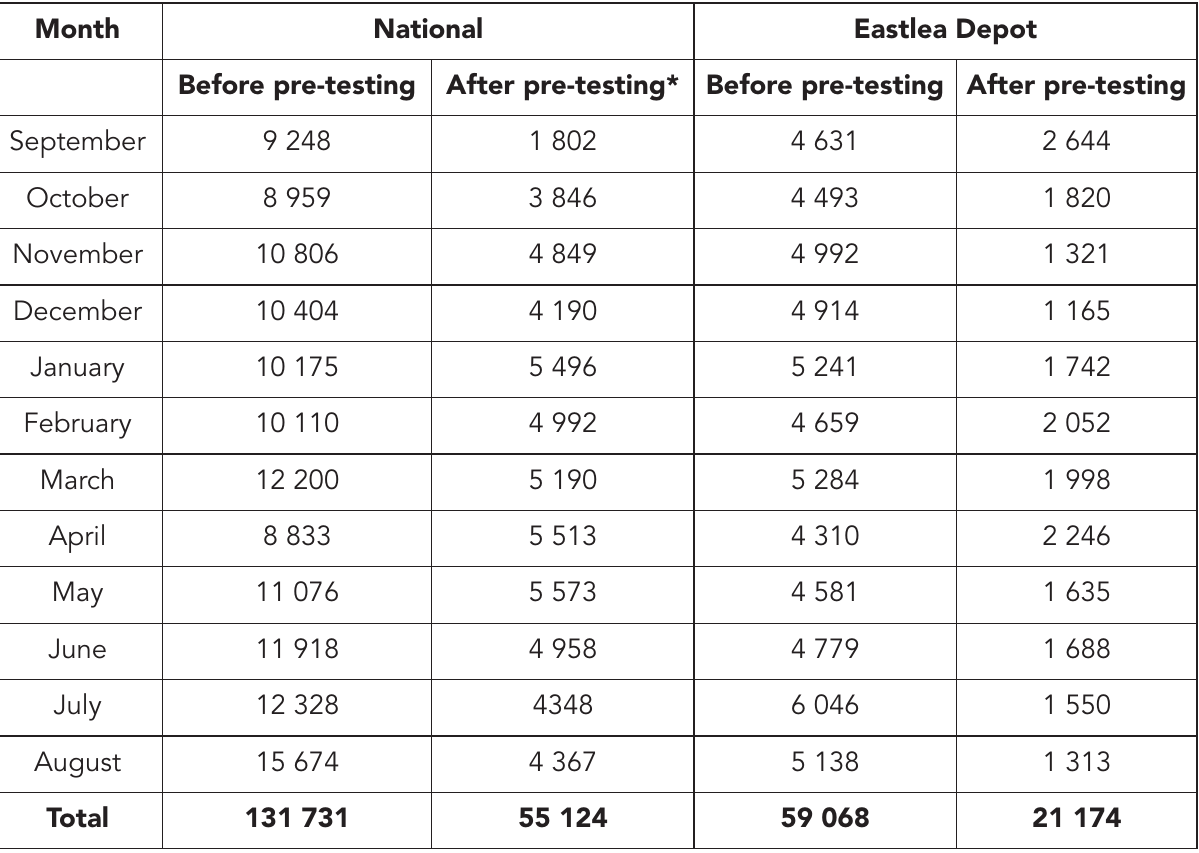
Table II: Learner drivers tested before and after the introduction of